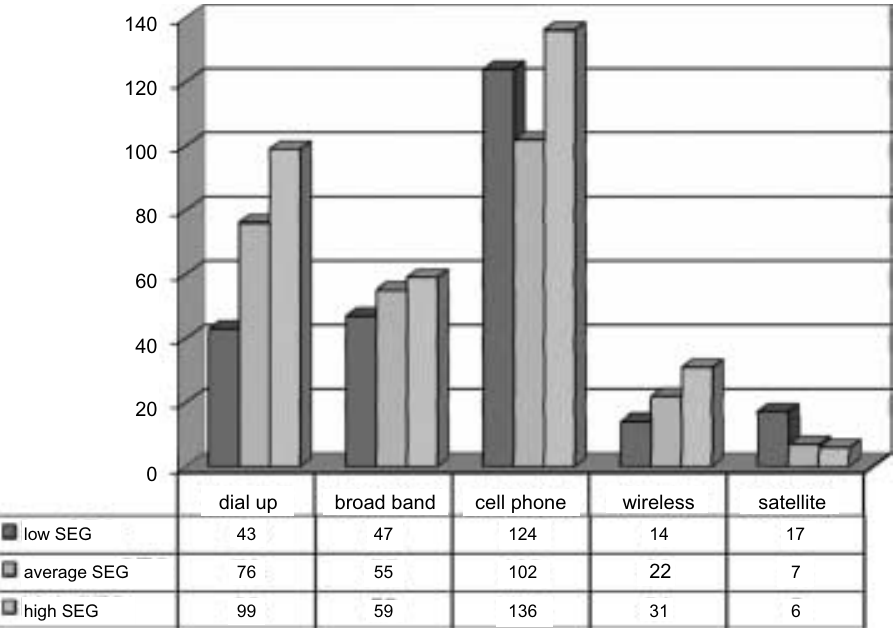
Figure 4. Type of connectivity off